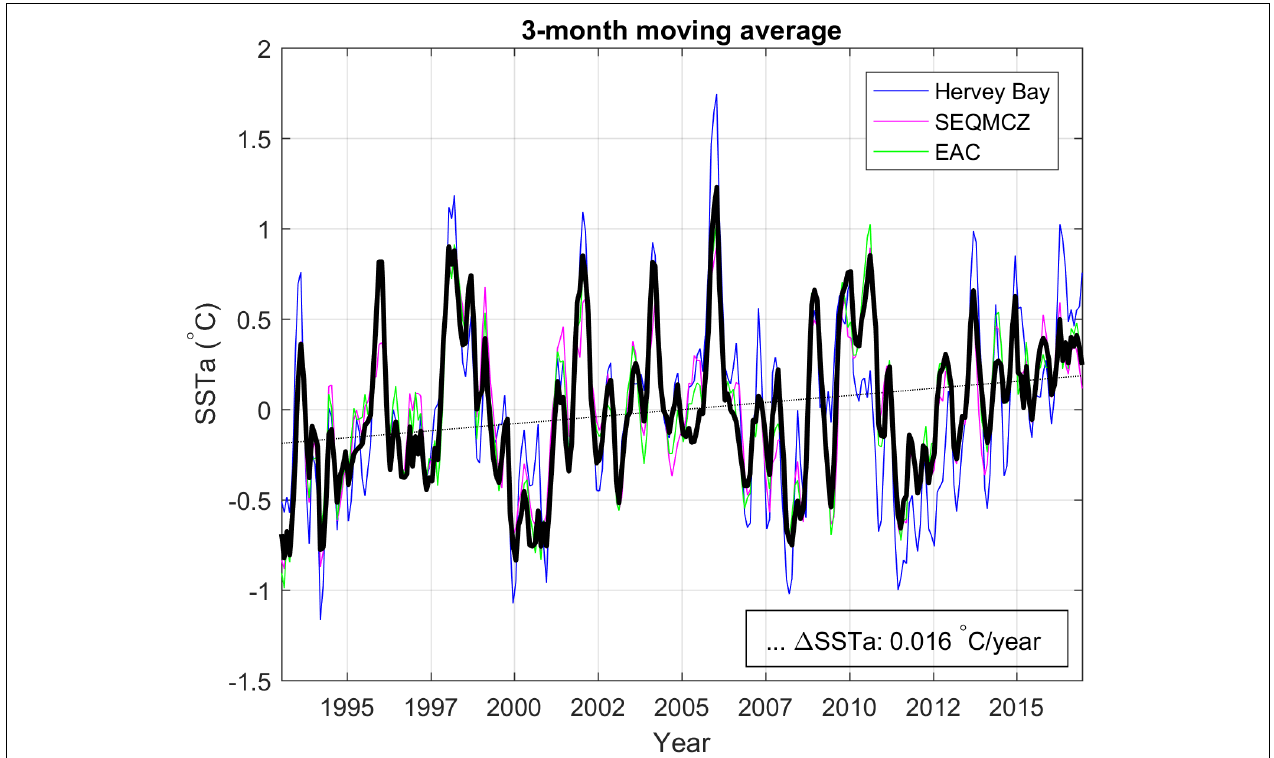
FIGURE 2 | Monthly SSTa ( ◦ C) using a 3-month moving average. The solid black line represents an average over the whole geographical area shown in Figure 1 . Blue, pink, and green lines represent SSTa for Hervey Bay, SEQMCZ, and EAC, respectively. The dotted line indicates the linear trend of regional